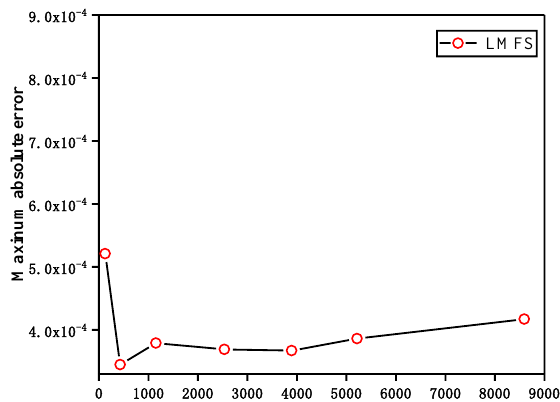
Figure 10. The convergence rate of the total nodes.